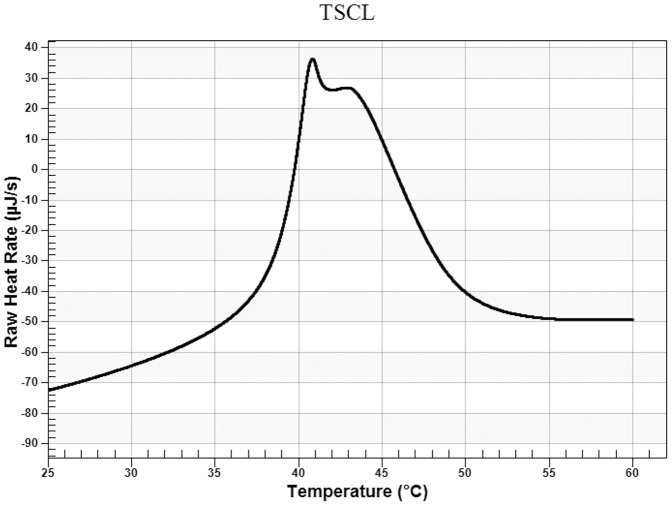
Differential scanning calorimetric scan (DSC) analysis of TSCL (DPPC∶DOAB∶DC-Cholesterol∶Cholesterol 80∶5∶5∶10) (molar ratio).